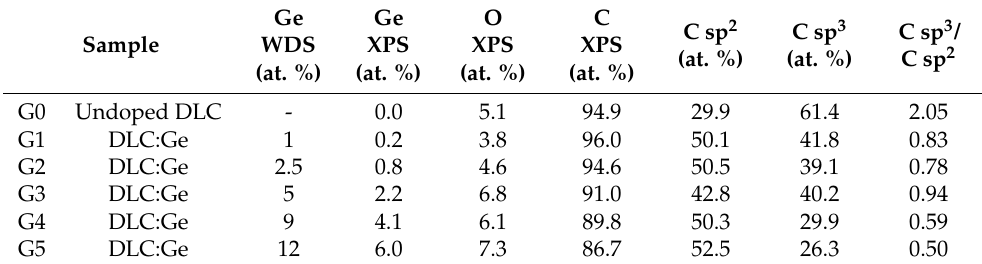
The high-energy resolved spectra of C 1s, Ge 3d and O 1s were collected with a pass energy of 10 eV and with a step of 0.05 eV, resulting in an overall energy resolution of 0.45 eV, measured on the width of the Ag 3d 5/2 line. Binding energy referencing was performed with respect to the C sp 2 contribution, which peaked at 284.3 eV. Quantification was performed using the integrated peak areas of the C 1s, Ge 3d and O 1s core level spectra after subtracting the standard Shirley‘s electron inelastic background and the atomic sensitivity factors given in ESCApe software, version 1.4 (Kratos Analytical Ltd., Manchester, UK). The C 1s spectra were analysed by peak fitting using the asymmetric pseudo-Voigt peak shape to separate the C sp 2 bonds [21] and using the symmetric Voigt curves to separate the C sp 3 contribution and other resolved bonding states in the C 1s and Ge 3d spectral envelopes. LEIS measurements were performed with an AXIS-Supra photoelectron spectrometer (Kratos AnalyticalLtd., Manchester, UK) using 4 He as